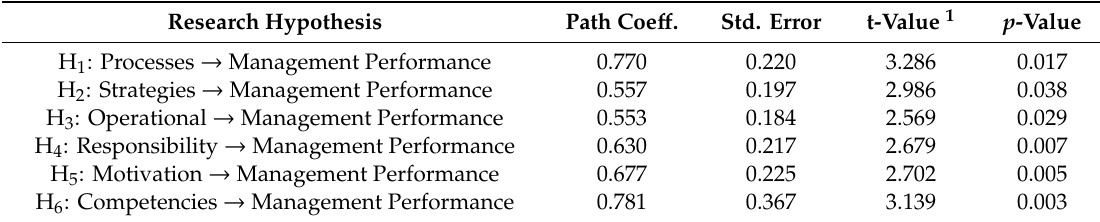
Table 7. Research hypothesis results, after performing